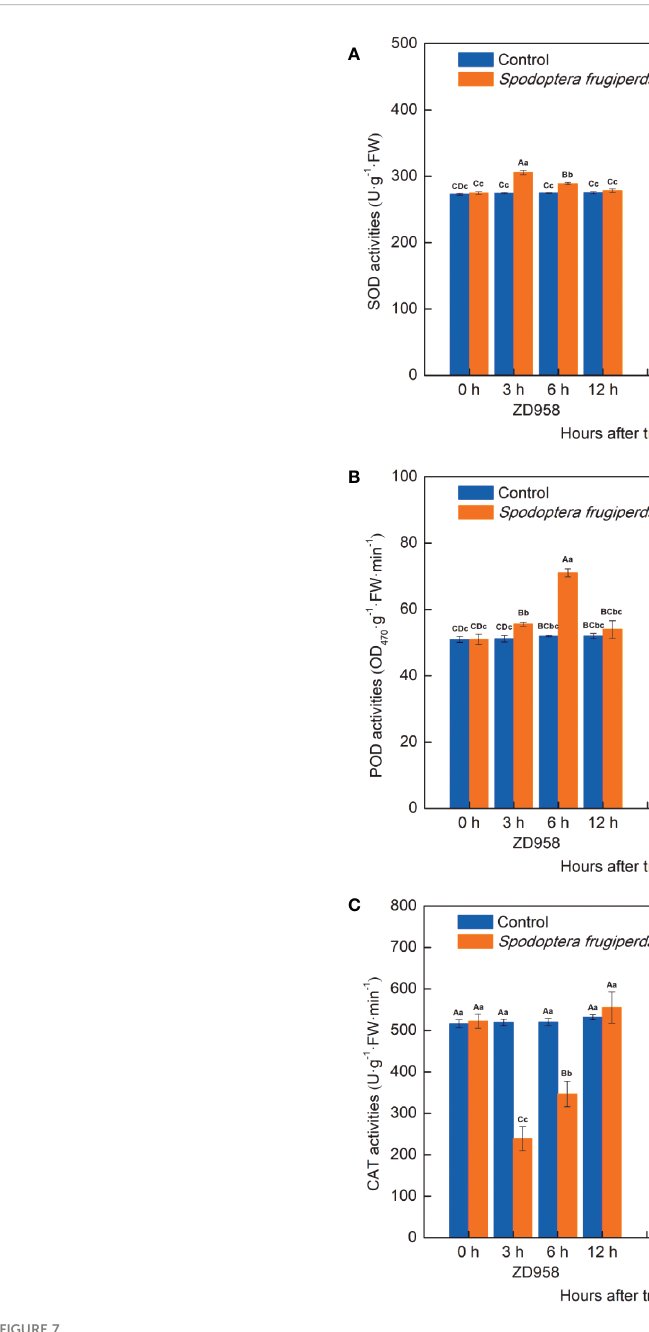
FIGURE 7 Effect of S. frugiperda infestation on antioxidant enzyme activity in maize leaves. (A) superoxide dismutase activity. (B) Peroxidase activity. (C) Catalase activity. Data are shown as means ± SD ( n = 3, every n represents the mean of three seedlings). Different letters indicate signi fi cant differences at P < 0.05. Capital letters represent differences between the two maize cultivars, while lowercase letters indicate differences between treatments within the same